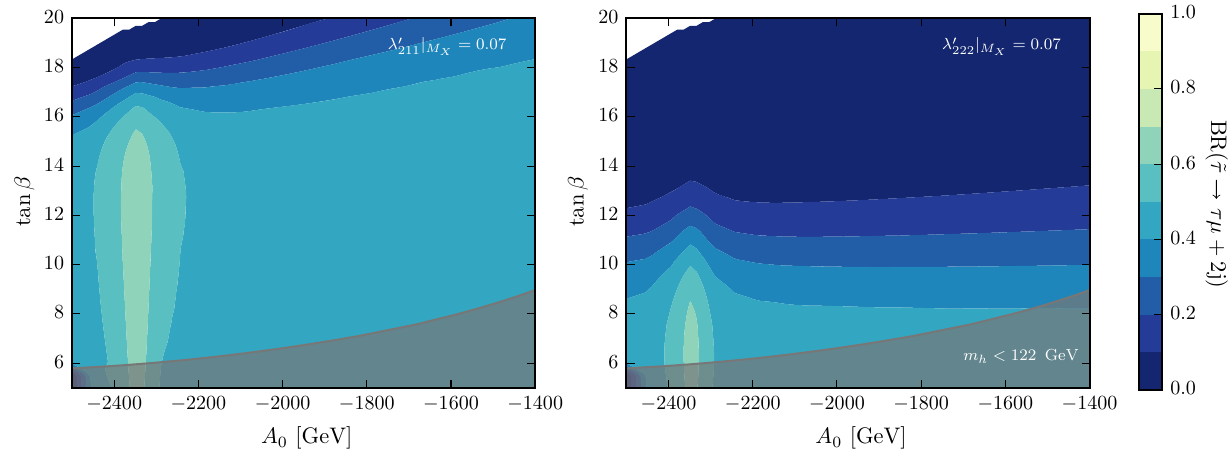
and M 1 / 2 = 1 TeV. The gray parameter space is excluded due to a | = 0 . 07 (left) and too light Higgs mass, whereas the white upper-left corner features a M X 211 = 0 . 2 TeV tachyonic 0